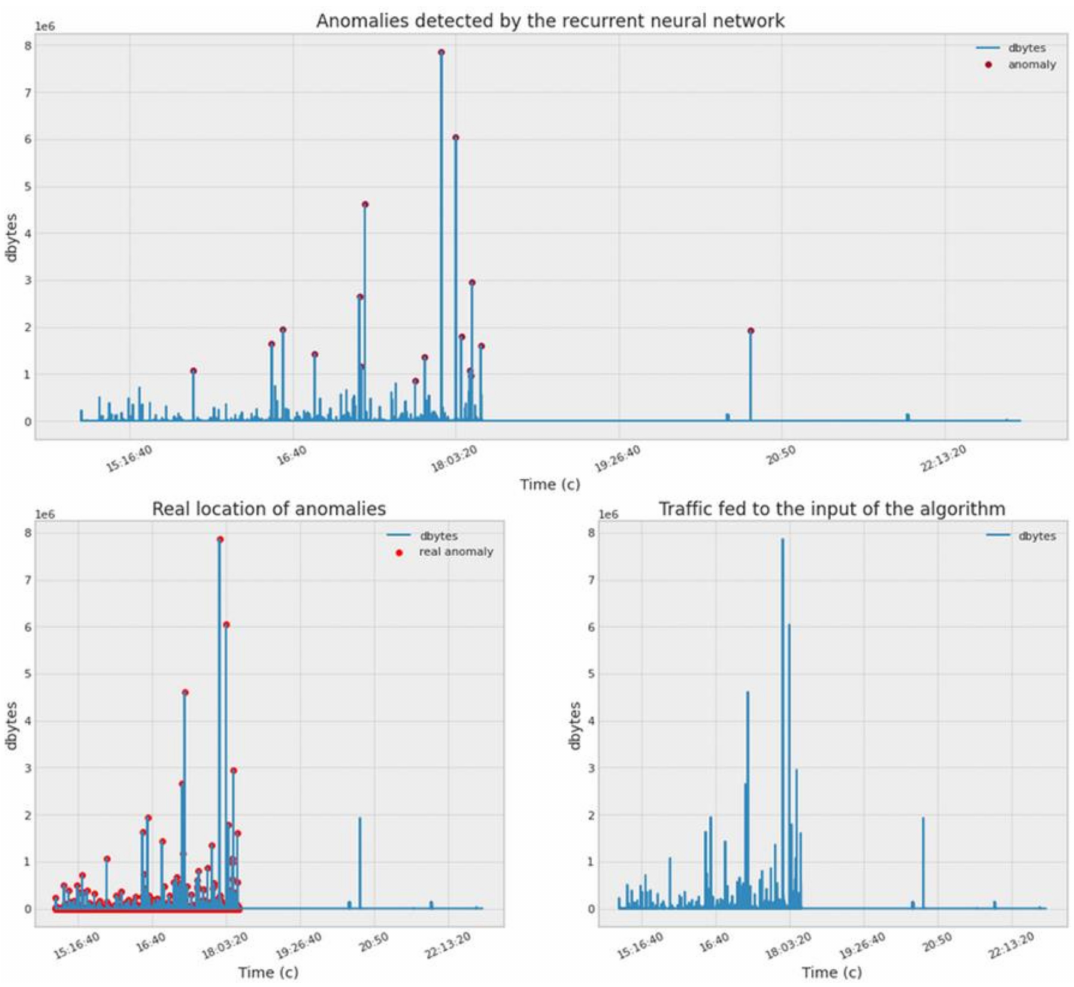
Figure 33. The result of the